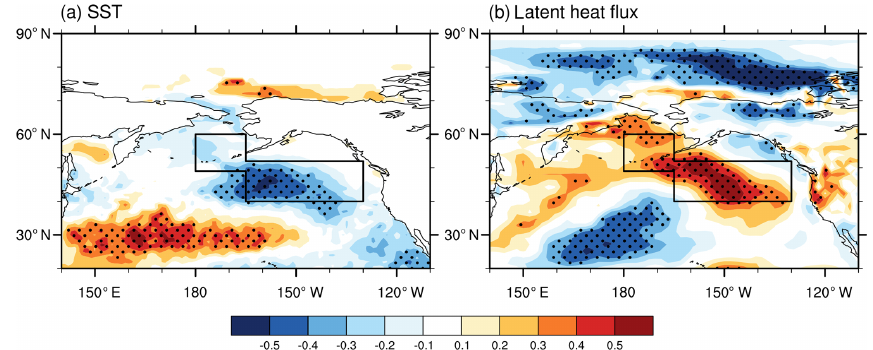
Figure 9. The CC between WSPD RS1 and (a) SST and (b) latent heat flux in November from 1979 to 2015. The black dots indicate that the CCs exceeded the 95% confidence level ( t test). The black box represents the BA area. The linear trend was removed.